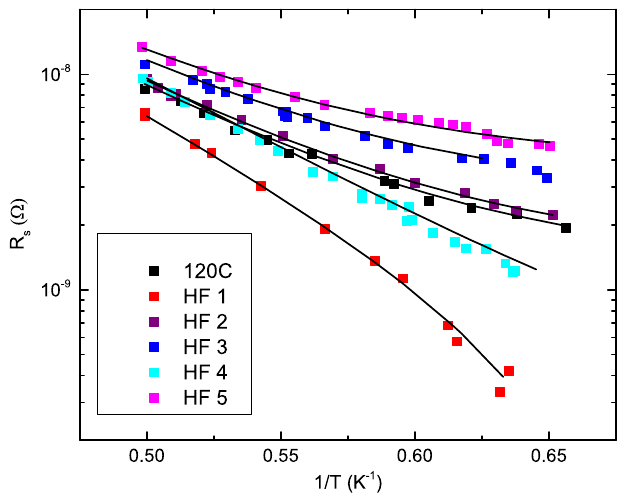
FIG. 6. Average surface resistance R s ¼ G=Q 0 at H peak (cid:4) 21 mT after multiple HF rinse cycles for the electropolished tumbled cavity TE1ACC002. Relative errors (cid:2) R s =R s are esti- mated at about 10% at 2 K and 50% at lowest temperatures ( (cid:3) 1 : 6 K ). Black lines represent fits to the data based on the weakly coupled BCS approximation using the code from [12].